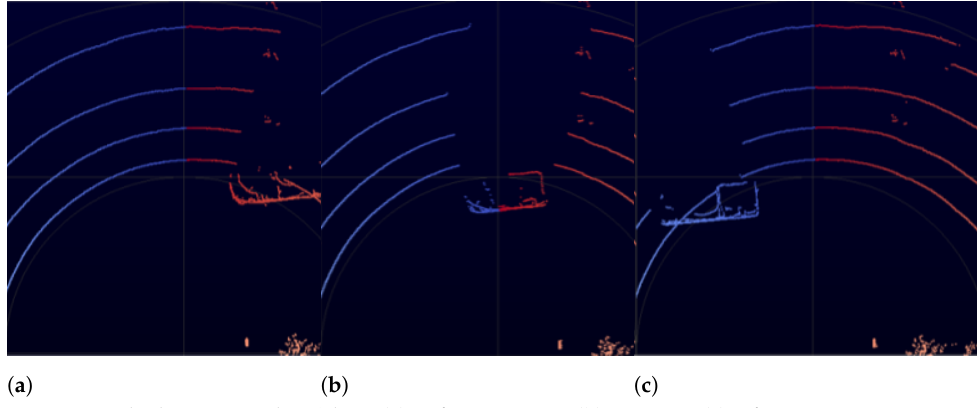
Figure 7. Vehicle crossing the 0 ◦ line. ( a ) Before Crossing ( b ) Crossing ( c ) After Crossing.